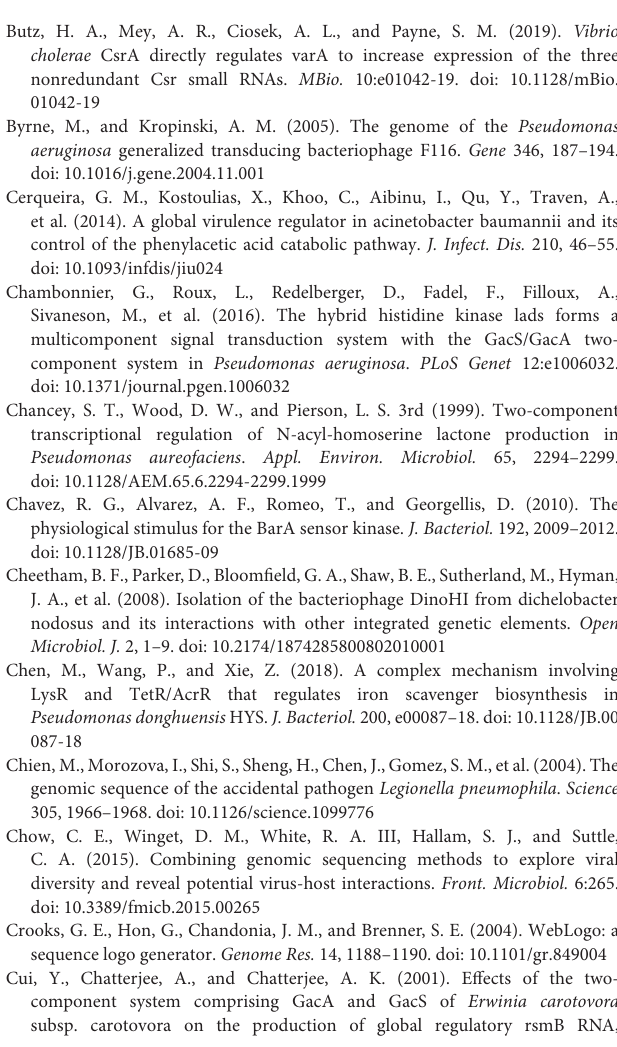
obtained from KEGG database (Kanehisa and Goto, 2000). Briefly, we inspected the presence of each gene using the KEGG ontology tool: csrA (K03563), barA Supplementary Table 2 | Number of proteins of each Rsm subfamily detected in the Pseudomonas genome database. The dataset was generated using the Pseudomonas orthologous groups (POGs) from the Pseudomonas genome database (Winsor et al., 2016). Non annotated Rsm paralogues within the POGs were identified by interrogating all available Pseudomonas genomes with BLASTP using the amino acid sequence of RsmA from Pseudomonas aeruginosa (PA0905) as query (Expect value cut-off = 1). Supplementary Table 3 | Number of Rsm paralogues per genome in Pseudomonas species. The table lists the number of different Rsm paralogues present in the chromosome of each Pseudomonas species studied in this work. For some species (e.g., P. aeruginosa or P. putida ), we included several different strains, some of them bearing different combinations of paralogues. Supplementary Table 4 | Amino acid sequence of Rsm paralogues in Pseudomonas species. For paralogue identification, we used a phylogenetic